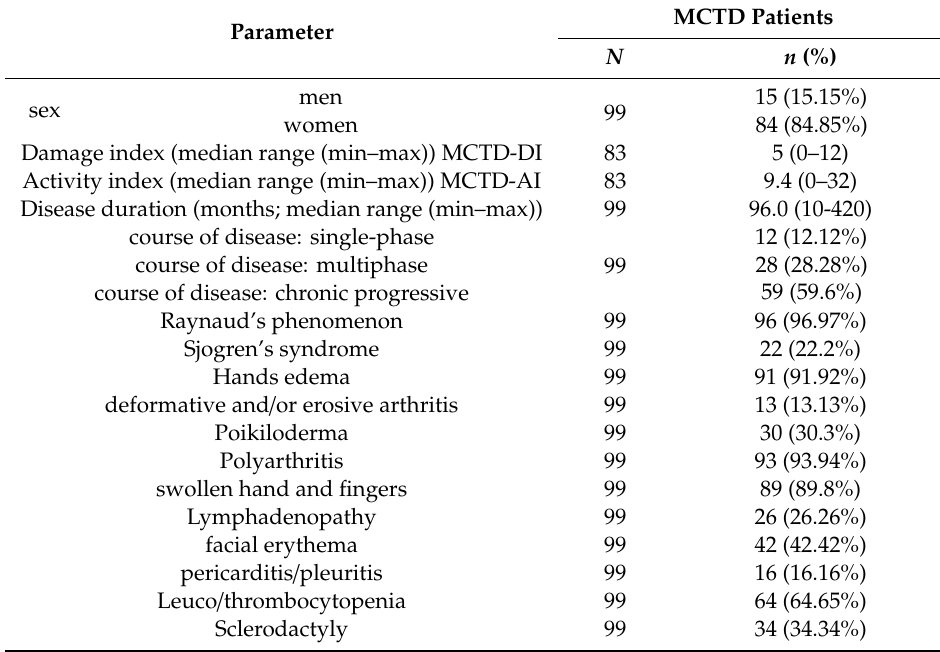
Table 1. Clinical and biochemical characteristics of the study